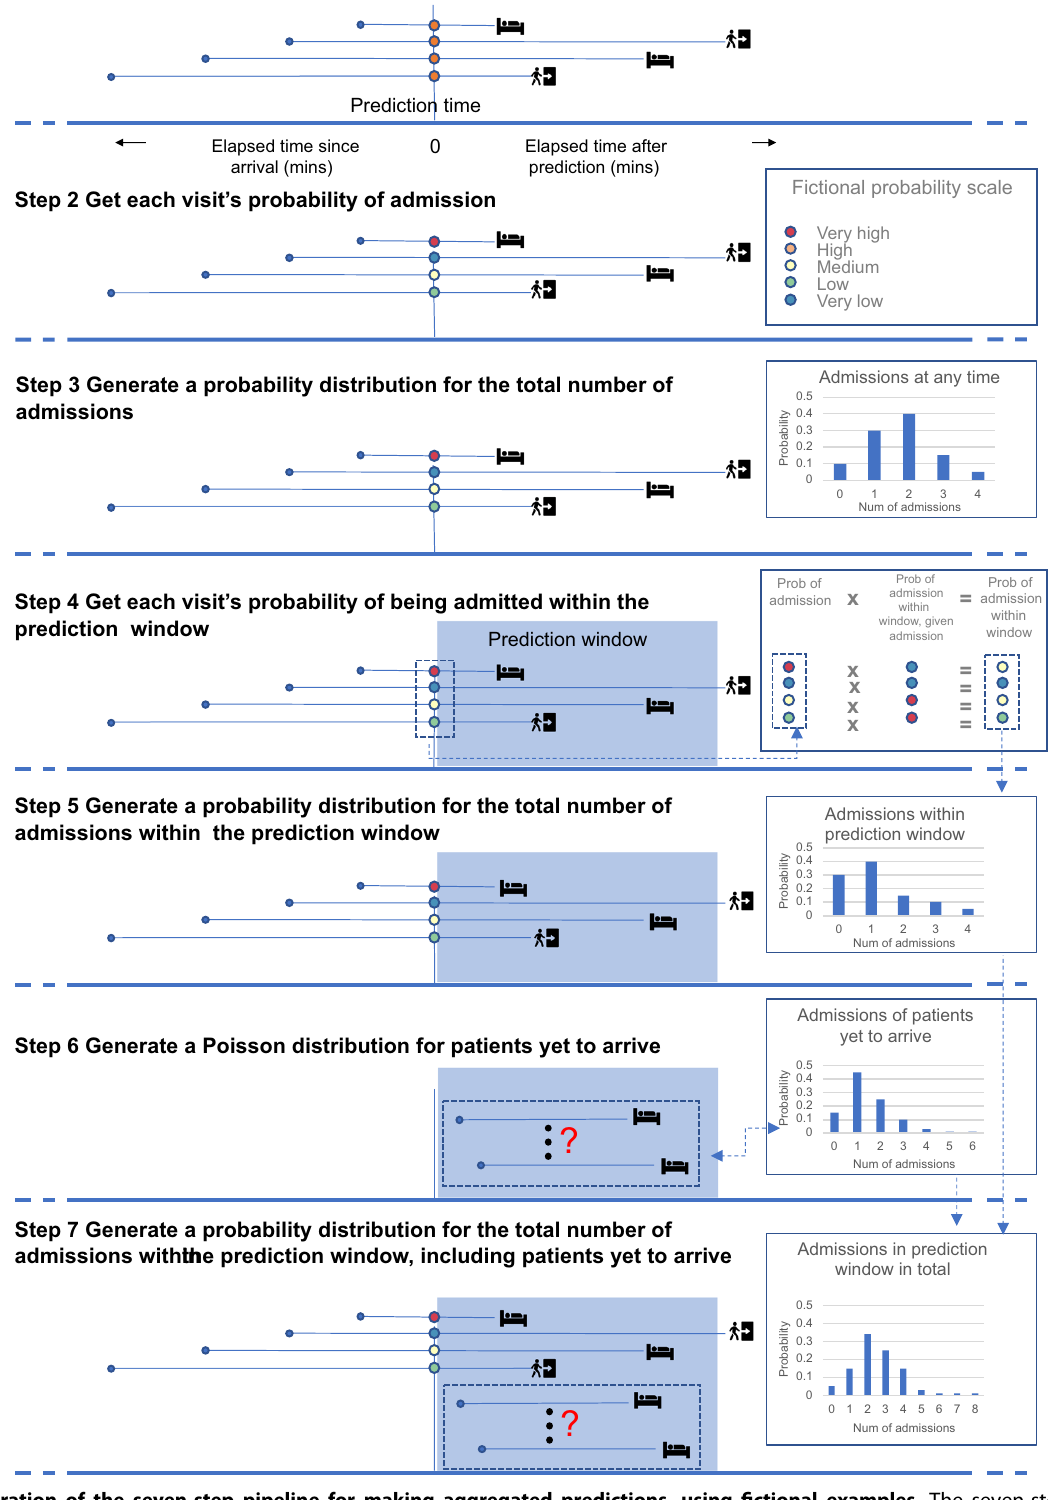
Fig. 7 Illustration of the seven-step pipeline for making aggregated predictions, using fi ctional examples. The seven-step pipeline is illustrated at the point of prediction, assuming there are four patients in the ED at that moment in time, and an unknown number of patients yet to arrive, who will be admitted within the prediction window. Figures on the right show fi ctional examples of the output from each